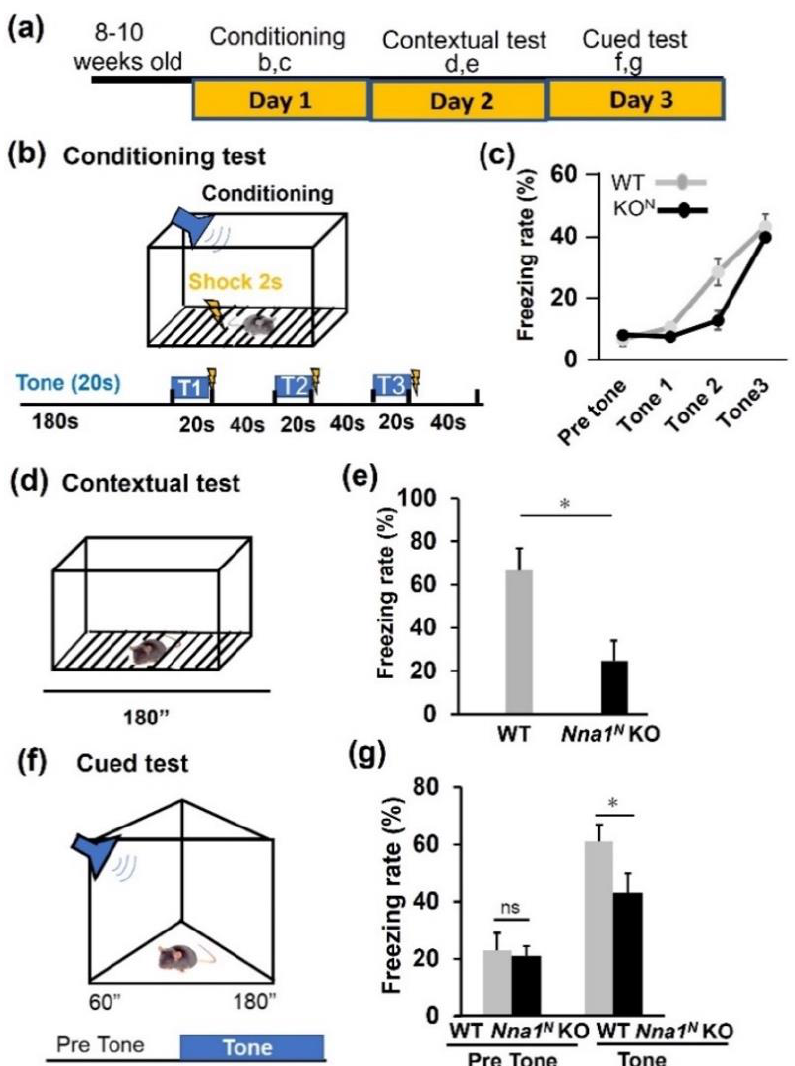
Figure 6. Contextual and cued memory in Nna1 N KO mice in the fear conditioning test. ( a ) Schematic representation of the conditioning test. ( b,c ) There was no significant difference between Nna1 N KO and WT ones in the conditioning tests’ freezing response. ( d,e ) Contextual test: freezing responses on the contextual testing 24 h after conditioning. Note a lower freezing response in Nna1 N KO mice compared with WT mice. p < 0.05, Student’s t -test. ( f,g ) Cued test: freezing responses on the cued testing 48 h after conditioning. Note the reduced freezing response in Nna1 N KO mice compared to the WT ones. WT, n = 6; Nna1 N KO, n = 10, * p < 0.05, Student’s t -test. All values presented are means ± SEM. “ns” means not